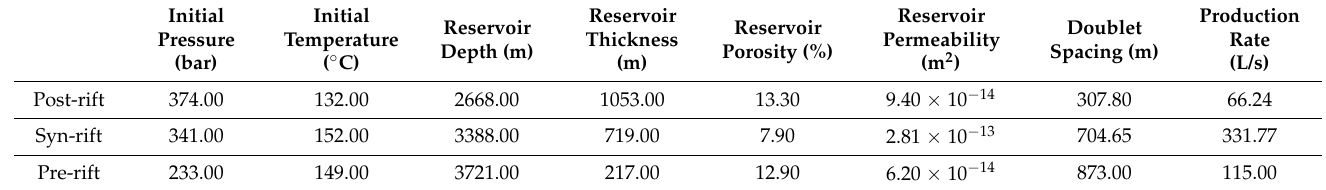
Table 4. Input parameters for model.